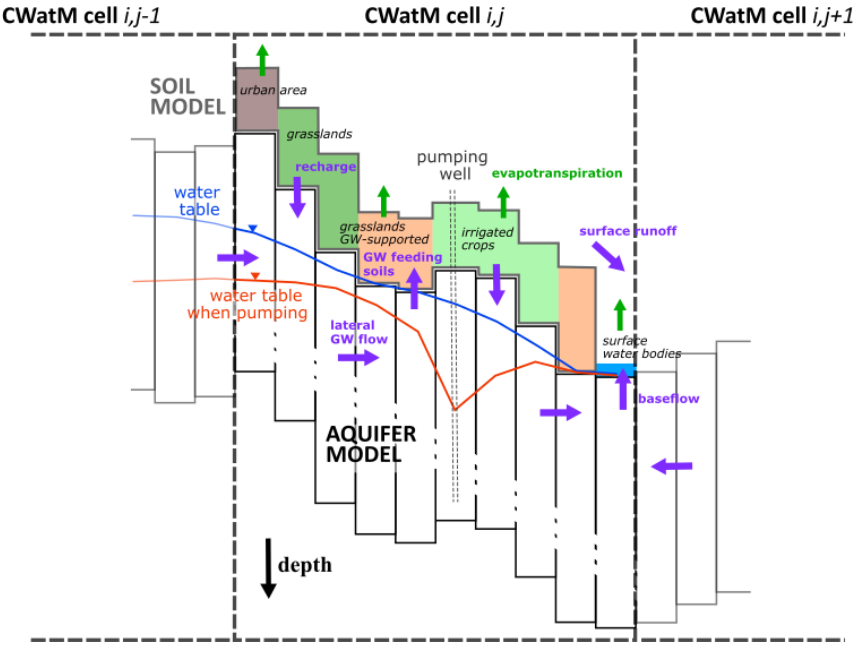
Figure 1. CWatM vertical and lateral sections focusing on coupling with MODFLOW. The CWatM cells are composed of five land cover types: grasslands, grasslands experiencing groundwater (GW) capillary rise, irrigated crops, urban areas, and surface water bodies. The figure illustrates the impact of aquifer pumping on the water table depth and consequently on baseflow and groundwater capillary rise toward